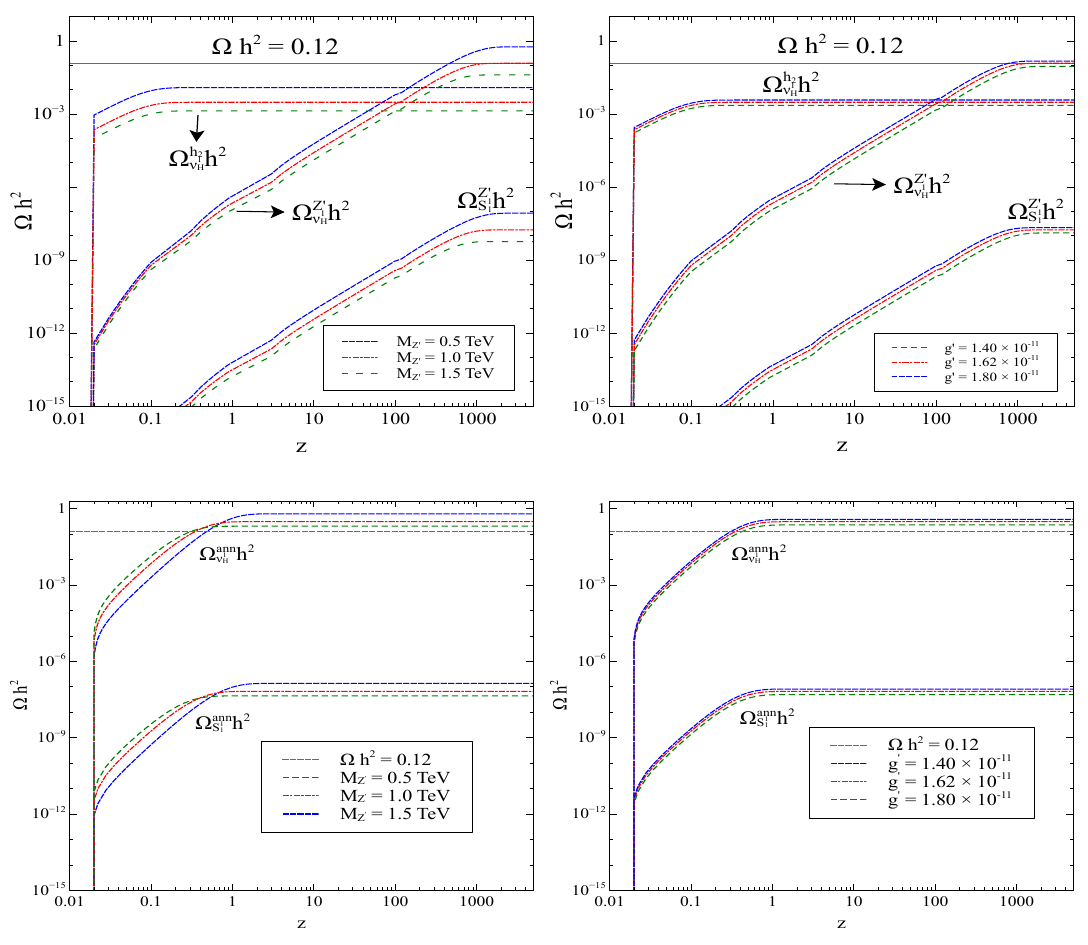
Figure 10 . Variation of relative relic density contributions of a two DM component scenario as a function of z for di(cid:11)erent values of M Z 0 (left panels) and g 0 (right panels). Top (cid:12)gures correspond to decay contributions while the bottom ones correspond to annihilation